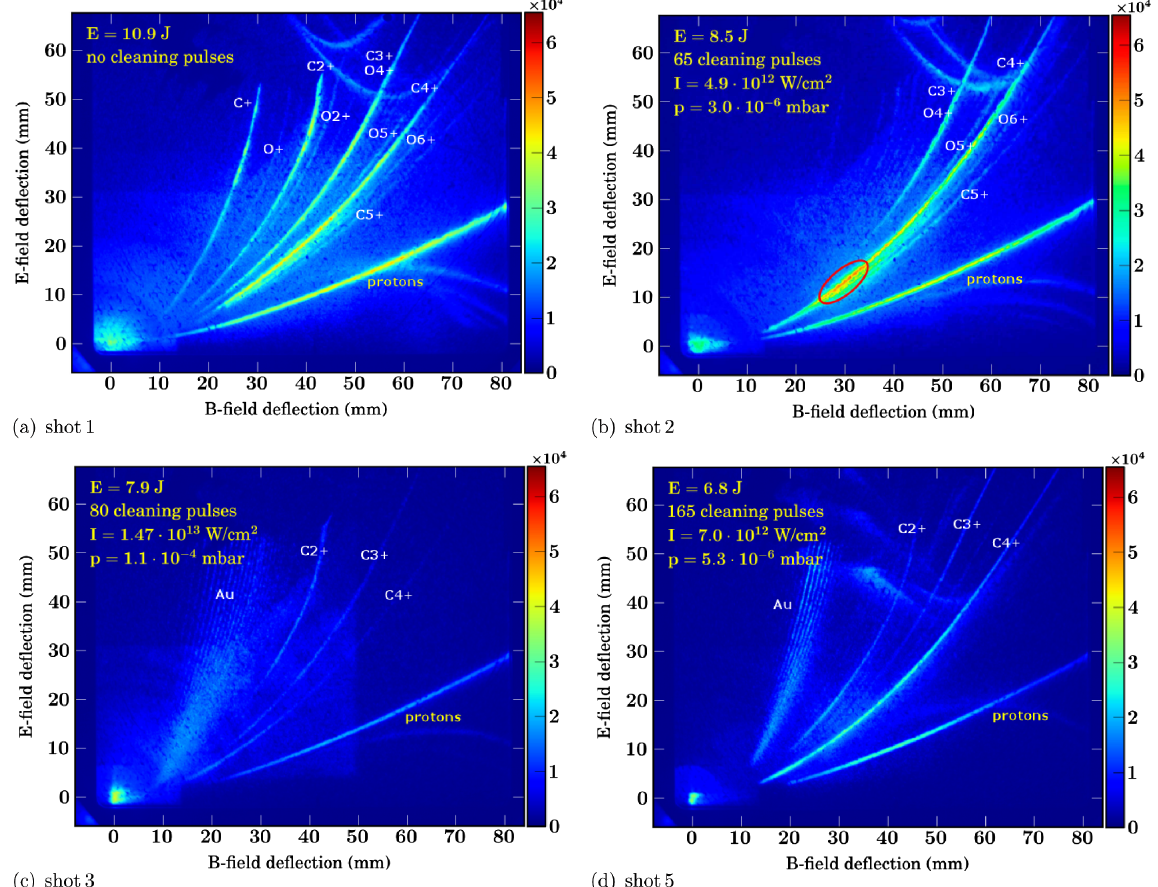
FIG. 1. Thomson parabola images of shots on 10 (cid:1) m thick Au foils with different cleaning pulse configurations and target chamber pressures. The signal intensity scale in MCP counts is given on the right. In (a), a reference shot without any cleaning pulses is shown. Besides an intense proton signal carbon ions up to charge state 5 þ and oxygen ions are present. In (b), at a desorption beam intensity of ¼ 4 : 9 (cid:3) 10 12 W = cm 2 , ions with low charge states vanish completely while C 4 þ has a higher maximum energy and shows an I des ¼ 1 : 47 (cid:3) 10 13 W = cm 2 , like enhanced signal between 0.18 and 0 : 35 MeV = u marked by the red ellipse. Increasing the intensity to I des ¼ 7 : 0 (cid:3) 10 12 W = cm 2 , like in (d), the proton signal and their maximum energy in (c), or the number of cleaning pulses to 165 at I des clearly decrease compared to (a) and gold ions are